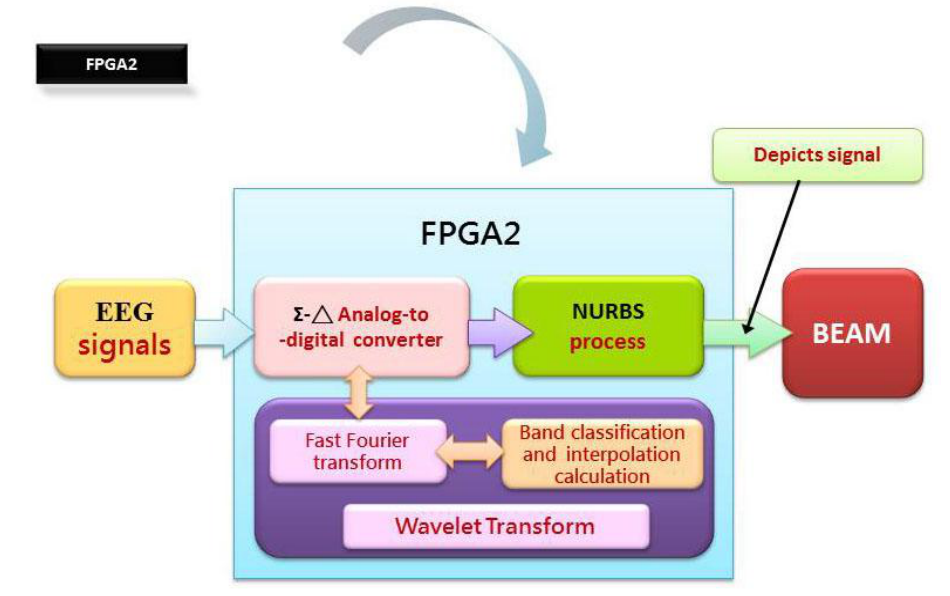
Figure 7. An embedded chip, FPGA2, design